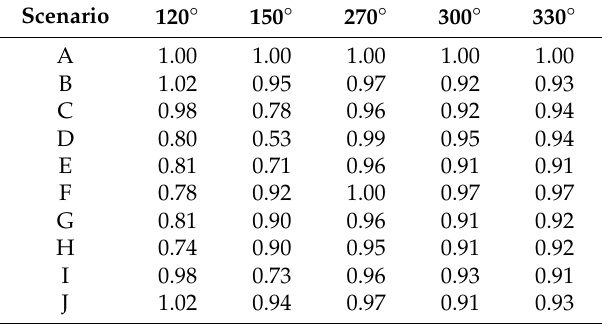
Table 1. Fraction of modeled wind speed at point WM 6m above roof top for scenarios B–J to wind speed in scenario A under di ff erent upper level flow directions (at 100 m AGL).